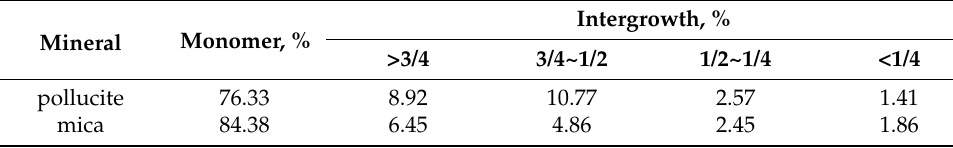
Figure 3. Cumulative distribution curve of particle size of the main cesium-containing minerals.